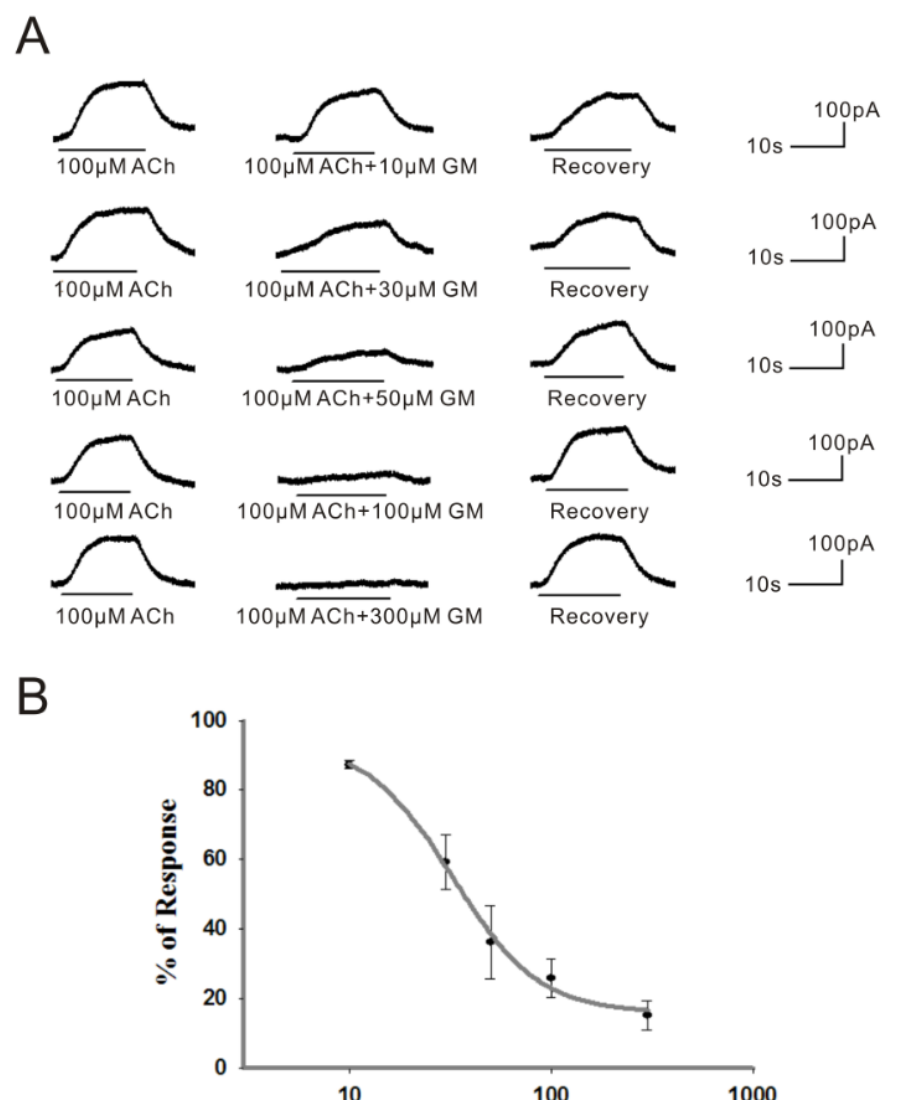
Figure 2. Different inhibition effects by various GM doses, and the dose-inhibition curve of GM. ( A ) With GM concentration increasing from 10 to 300 μM, the blocking effect increased gradually. The BK current was nearly completely blocked in the presence of 300 μM GM. The above results were obtained from the same cell at −50 mV; ( B ) The curve was derived by co-application of 100 μM ACh and increasing concentrations of GM. Only peak current values are plotted, expressed as the percentage of the peak control current evoked by ACh alone. Each point is the mean ± SD of 5